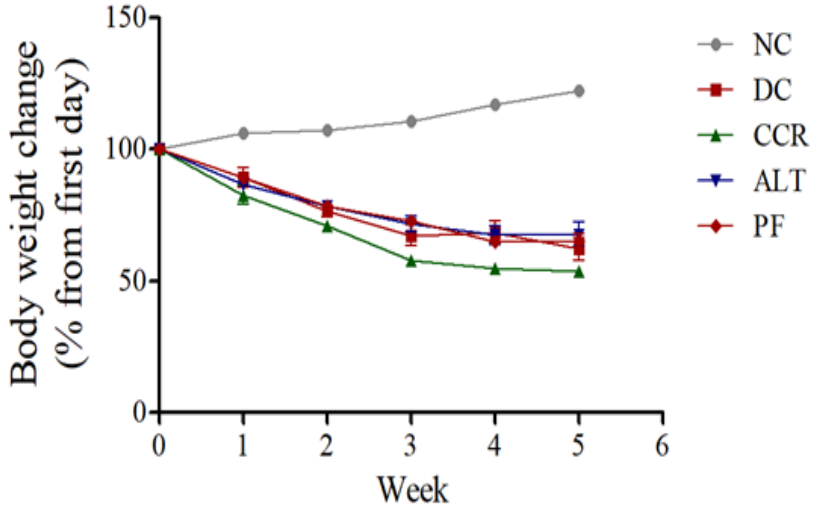
Figure 2. Effects of various intermittent fasting protocols on rat body weight. The graphs show the average body weight per group from the first day of the fasting protocols to the end of the study. The data revealed no significant changes in body weight during the study period in all diabetic groups. However, there was a significant difference in all of the diabetic versus control groups ( p < 0.01). Data are expressed as the mean ± standard error of the mean. NC = Control, DC = Diabetes, CCR = Continuous calorie restriction, ALT = Alternate day calorie restriction, PF = Calorie restriction for 2 days.